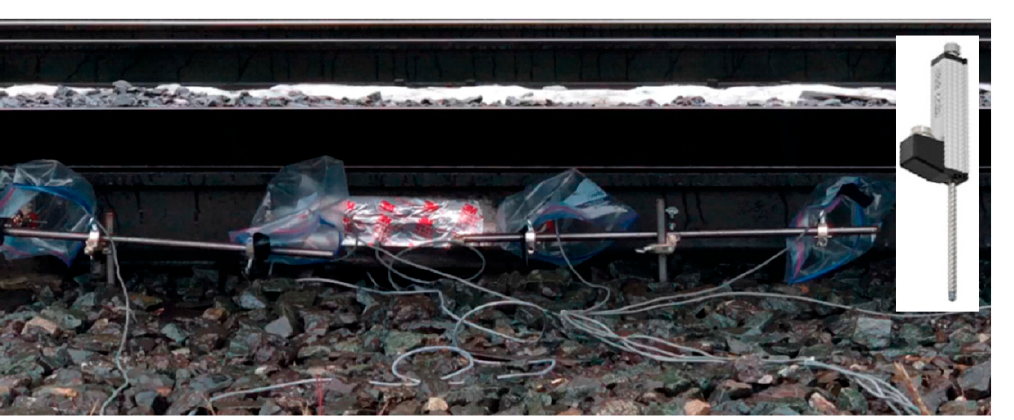
Figure 6. The test zone, with the timber and EIC sleepers shown with the instrumentation layout.